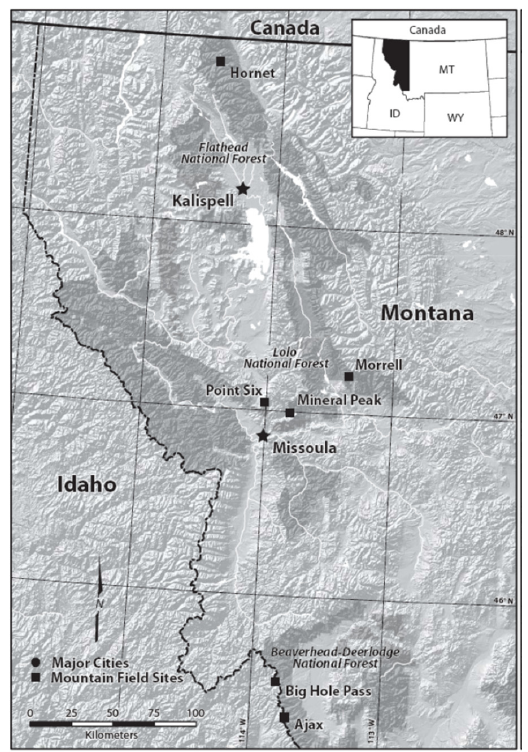
Figure 1. Terrain map of six study sites in western Montana. The Continental Divide is marked by a black dashed line.